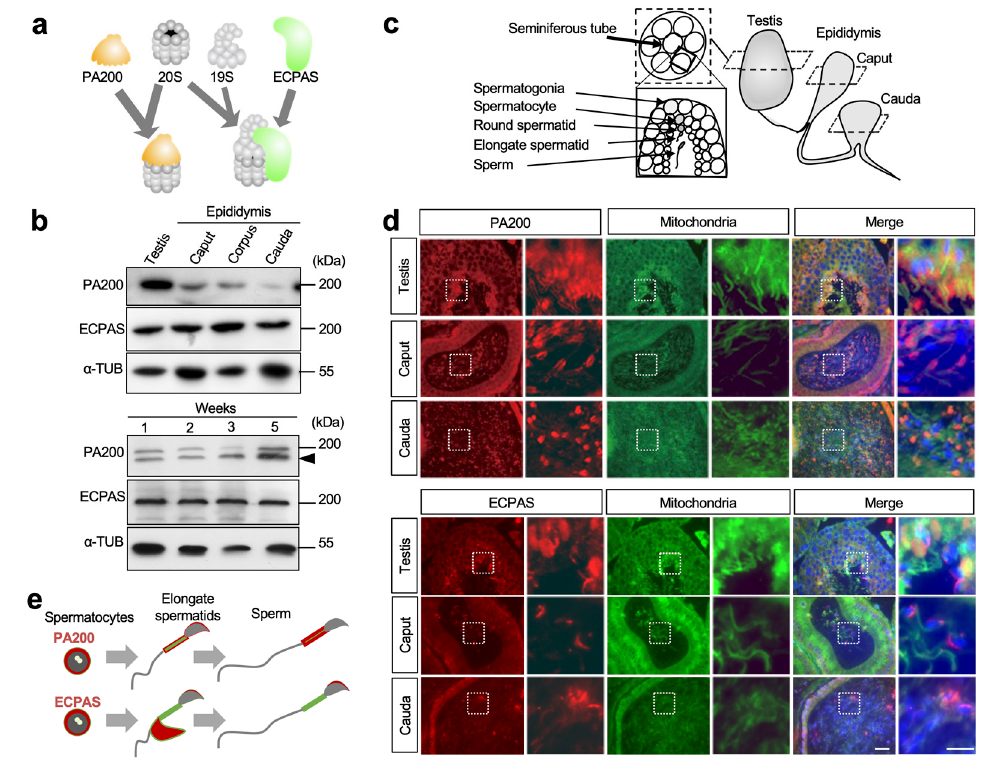
Figure 1. PA200 and ECPAS expression patterns in male reproductive organs: ( a ) Schematic representation of proteasome regulators. PA200 (orange) directly binds to 20S core particle (CP) and controls protease activity. ECPAS (green) binds to 26S proteasome and regulates its assembly; ( b ) Expression pattern of PA200 and ECPAS in the testes and epididymides. Arrowhead: non-specific PA200 band; ( c ) Schematic representation of male reproductive organs. For immunostaining, sections from each organ were used (broken lines). Spermatogenesis progresses from the outside to the inside of the seminiferous tubes; ( d ) Fluorescent images of the testes and epididymides stained with anti-PA200 Ab (red), anti-ECPAS Ab (red), MitoTracker (green), and DAPI (blue): (left) scale: 20 µ m; (right) enlarged images of dashed boxes at left; scale: 10 µ m; ( e ) Image showing the localization of PA200 and ECPAS during spermatogenesis.